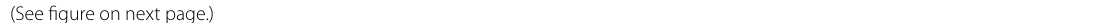
Fig. 2 In vivo toxicity testing: Impact of ursolic acid on liver ( a ) and brain ( b ) enzyme activities. Liver α carboxyl esterase and brain acetyl choline esterase activities were carried out using pooled liver/brain tissues from different fishes in the same group after 48 h of treatment. c Histopathology analysis: fish were injected with PBS and ursolic acid intramuscularly. After 48 h, the fish were sacrificed and preserved immediately in 10% formalin. They were embedded in paraffin blocks, sectioned, stained with Hematoxylin and eosin and imaged using bright field microscope. A–D represents histopathology of liver and muscle of untreated and ursolic acid (UR) treated